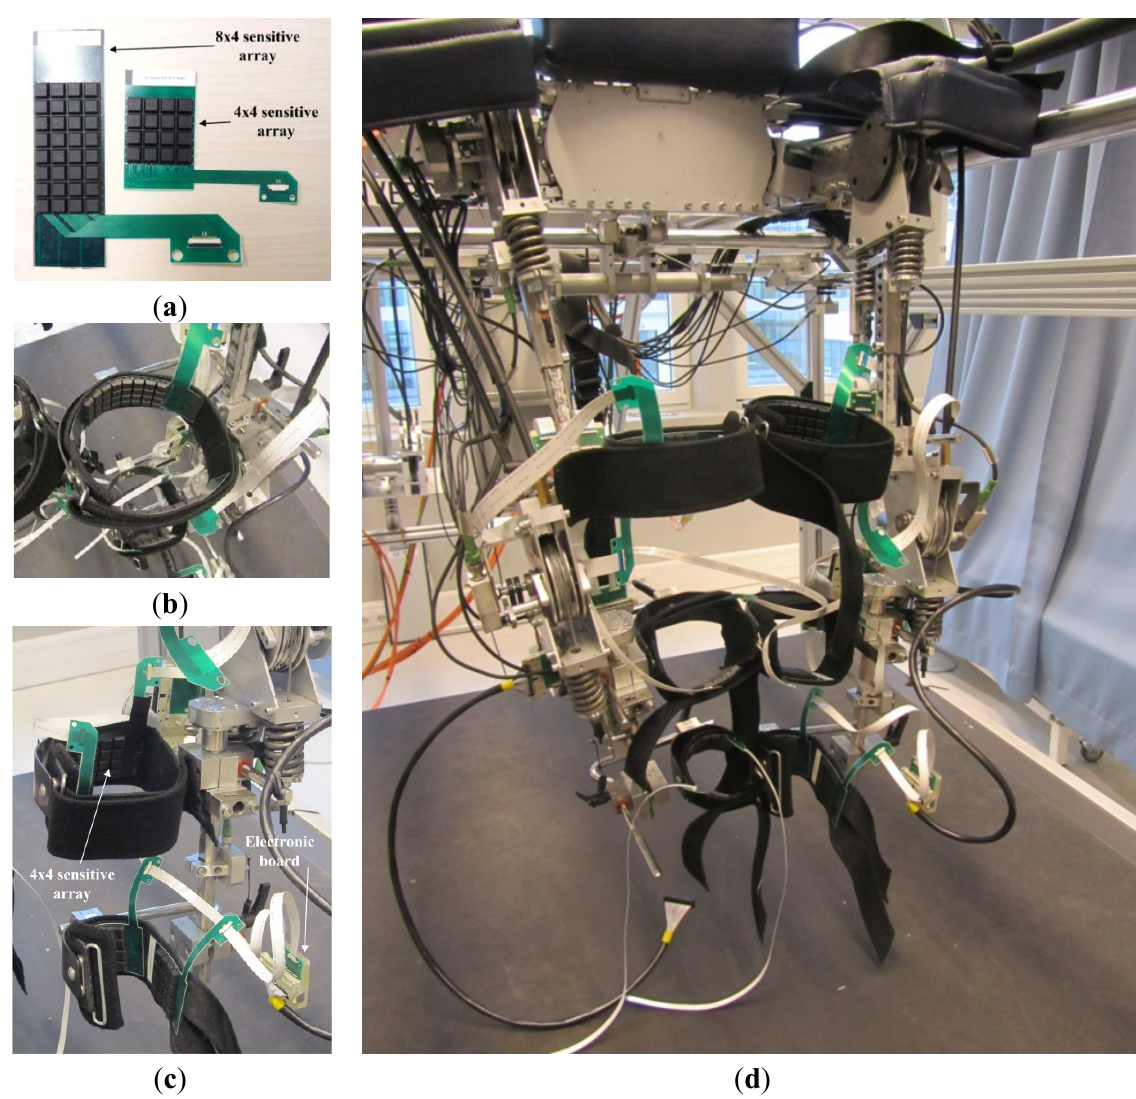
Figure 16. New PSP2.1-based LOPES sensorized cuffs. ( a ) Overview of the 8 × 4 and 4 × 4 sensitive arrays; ( b ) sensorized thigh cuff; ( c ) sensorized shank and ankle cuffs; ( d ) overview of the LOPES with all of the six cuffs endowed with PSPs